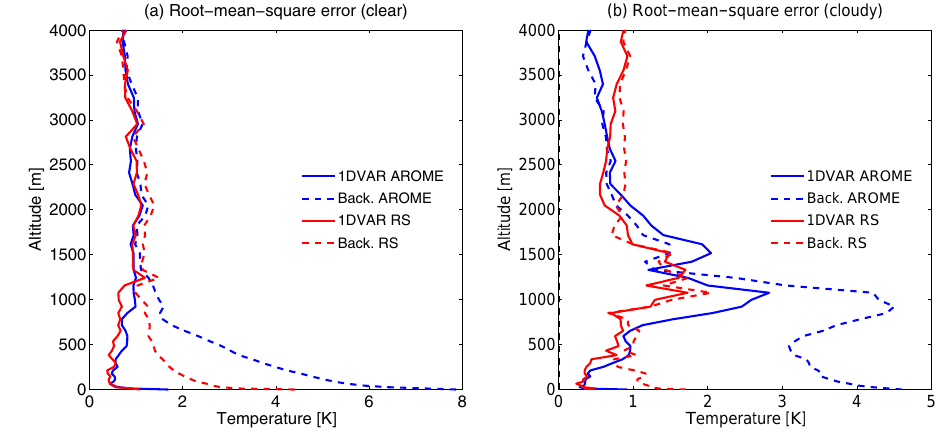
Figure 13. Vertical of profiles root-mean-square errors of 1DVAR retrievals using the previously launched radiosonde (red line) or the AROME forecasts (blue line) as backgrounds. Comparison with the persistent method where the last RS is used as an estimate of the current conditions (dashed red) and the AROME forecast errors (dashed blue). Here, the weather station is included in the 1DVAR from RS to improve the temperature retrieval at the surface (1.5m). Statistics on 56 clear-sky profiles (a) and 25 cloudy-sky profiles (b) .